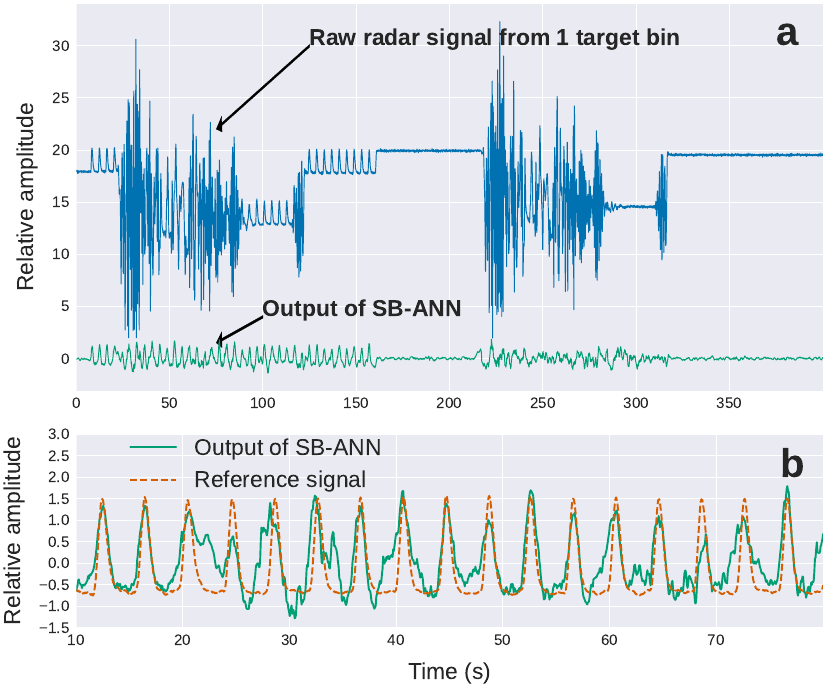
Figure 6. ( a ) Raw radar signal at bin 25 (blue line) and processed signal after applying SB-ANN (green line). ( b ) Processed signal (green line) from figure ( a ) in the interval between 10 and 75 s that includes gantry movement as well as the original RMP